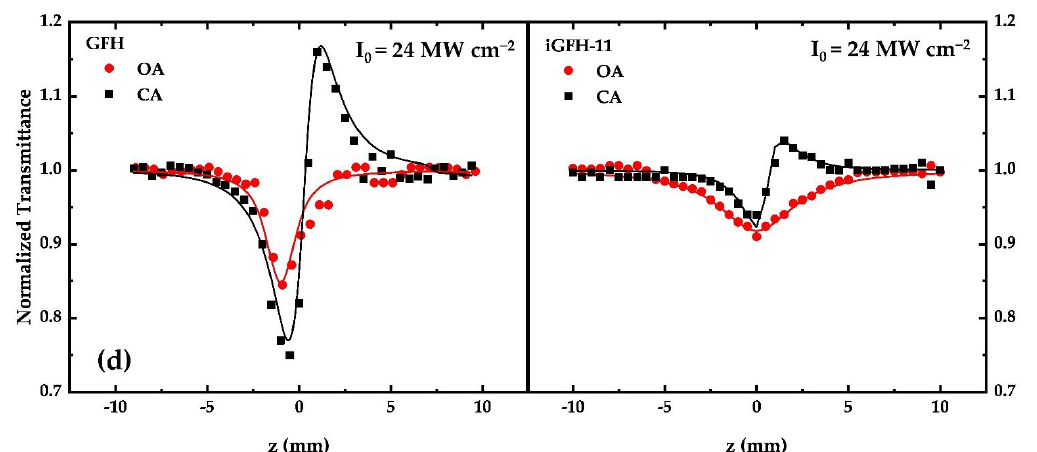
Figure 4. Representative Z-scan recordings showing the evolution of the NLO properties of non- irradiated and irradiated ( a ) G, ( b ) GO, ( c ) GF and ( d ) GFH dispersions. It is important to note that since the solvents used for the dispersions (i.e., DMF, dis- tilled water and acetone) did not exhibit any NLO response under the present experi- mental conditions the Z-scan recordings directly reveal the sign and magnitude of the NLO response of the non-irradiated and irradiated dispersions. Therefore, as shown from the Z-scan measurements, G, GO, GF and GFH were all found to exhibit an important NLO response under ns laser excitation. More specifically, all samples were found to ex- hibit reverse saturable a bsorption (RSA) behavior (i.e., Imχ (3) > 0), attributed to two-pho- ton absorption (2PA) and/or excited-state absorption (ESA), as has been discussed in de- tail elsewhere [46]. It is interesting to state at this point that, although saturable absorption (SA) has to be expected (due to the flat absorption spectra of all the samples in the visible region, suggesting resonant character excitation), RSA behavior was observed (for both non-irradiated and irradiated samples). This last observation suggests that the operational mechanism responsible for the NLO absorption under ns excitation conditions is most probably due to 2PA and/or ESA. This can be further understood by considering that the